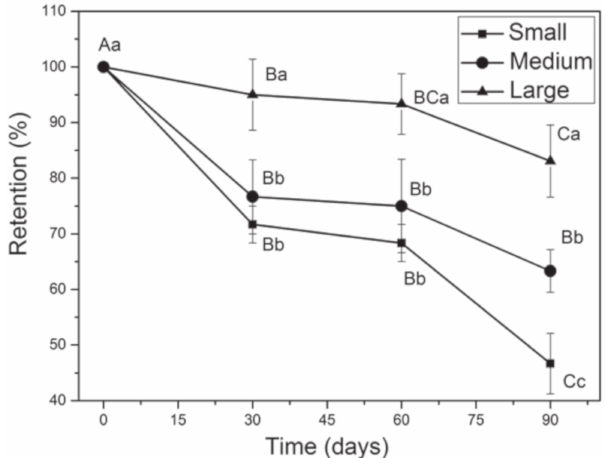
Fig. 2. Retention rate of tags for the different size classes of Lophiosilurus alexandri evaluated every 30 days for a pe- riod of 90 days. Means followed by different letters (upper- case between days and lowercase between sizes) differ significantly ( p < 0.05) by two-way ANOVA followed by Tukey